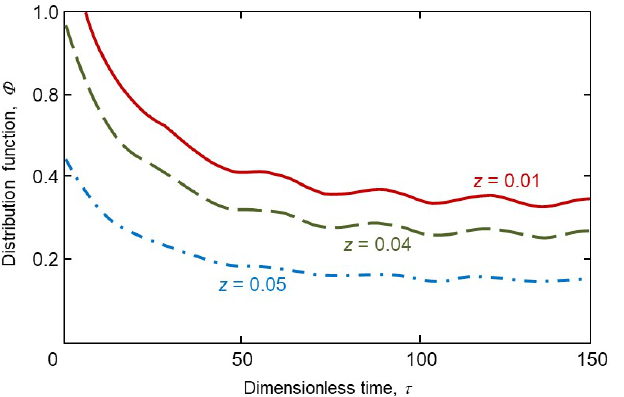
Figure 4. Particle-radius distribution function Φ ( z , τ ) versus dimensionless time τ accordingly to the analytical solutions (44) and (55).